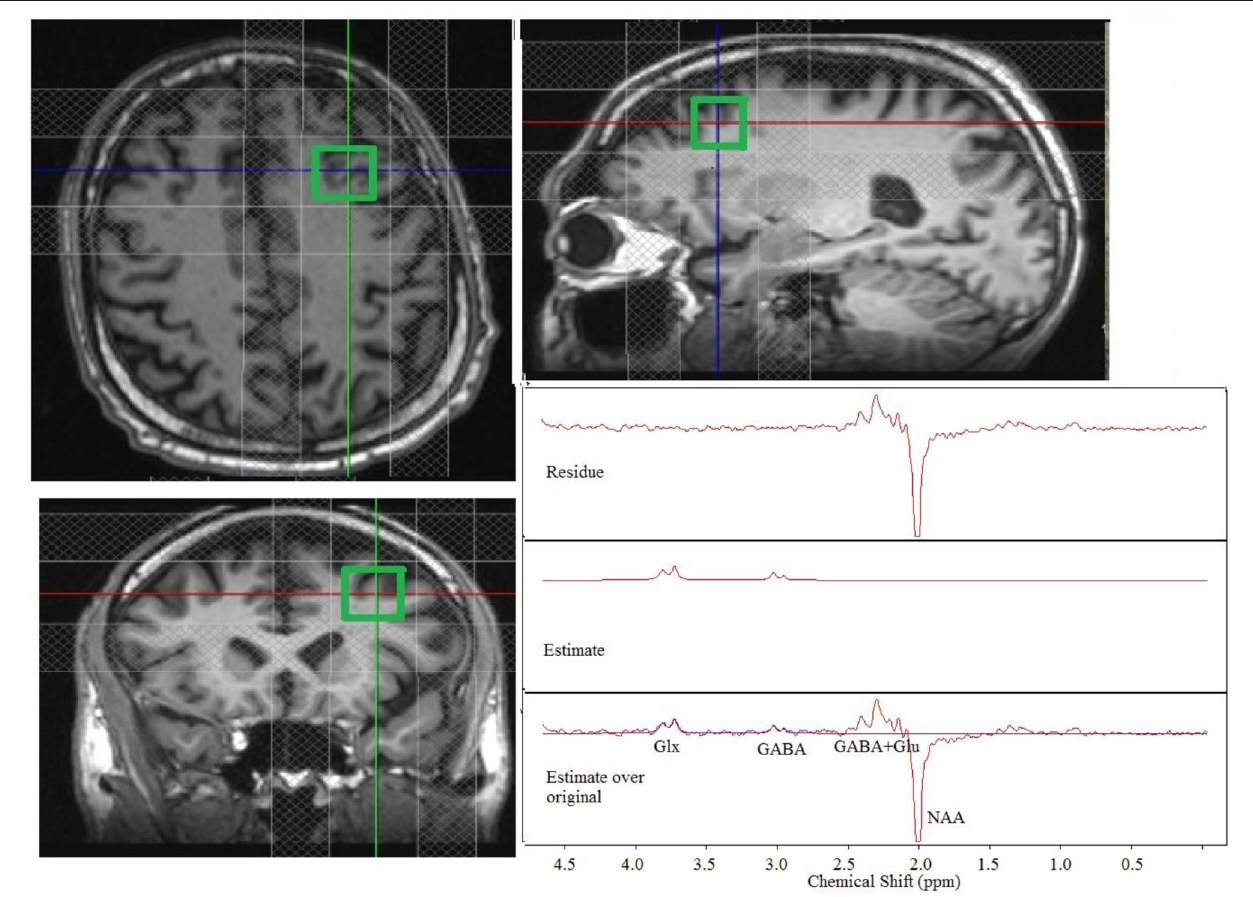
FIGURE 1 | Placement of a 2 × 2 × 2 cm 3 dorsolateral prefrontal cortex voxel with the outer volume suppression bands and representative single-patient MEGA-PRESS edited spectra (original, estimate and residue). Glx, glutamate + glutamine; GABA, gamma aminobutyric acid; Glu, glutamate.